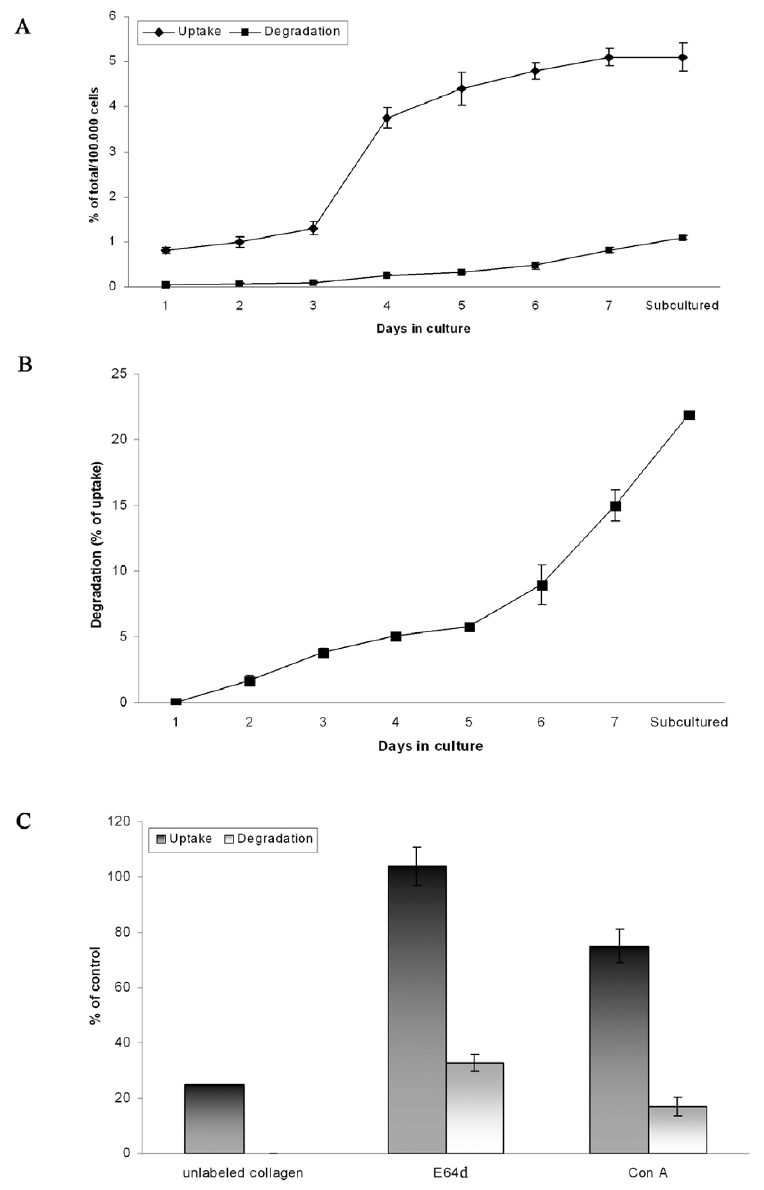
Figure 3 Uptake and degradation of denatured collagen by rat HSCs as a function of cell culture time and the effect of inhibitors of lysosomal function on these processes . (A) At each day, cells cultured in 6-well plates were washed, pre- incubation for 45 min at 37°C, and then incubated for 2 h at 37°C with 10 μ g/ml 125 I-TC-collagen. After washing, cells were lysed to determine total cell-associated radioactivity (= the sum of acid-soluble and acid-precipitable radioactivity), which was taken as a measure of total uptake of 125 I-TC-collagen. Acid-soluble radioactivity was taken as a measure of degradation of 125 I- TC-collagen. (B) The calculated percentage of internalized 125 I-TC-collagen degraded by cells. Results are shown as means ± SD for triplicate wells and represent one of three similar experiments. Data are normalized for cell number. Cells were counted on the indicated days as described in Materials and methods. (C) Sub-cultured (first passage) HSCs were washed, pre- incubation for 45 min at 37°C, and then incubated at 37°C with 125 I-TC-collagen for either 30 min in the absence or presence of excess unlabeled denatured collagen (100-fold) or for 2 h in the absence or presence of E64d (100 μ M) or concanamycin A (Con A, 1.5 μ M). Uptake and degradation were determined as described above. Data represent either average of duplicate determinations (unlabeled collagen) or means ± SD for triplicate determinations (E64d and Con A) and are representative for at least two such experiments